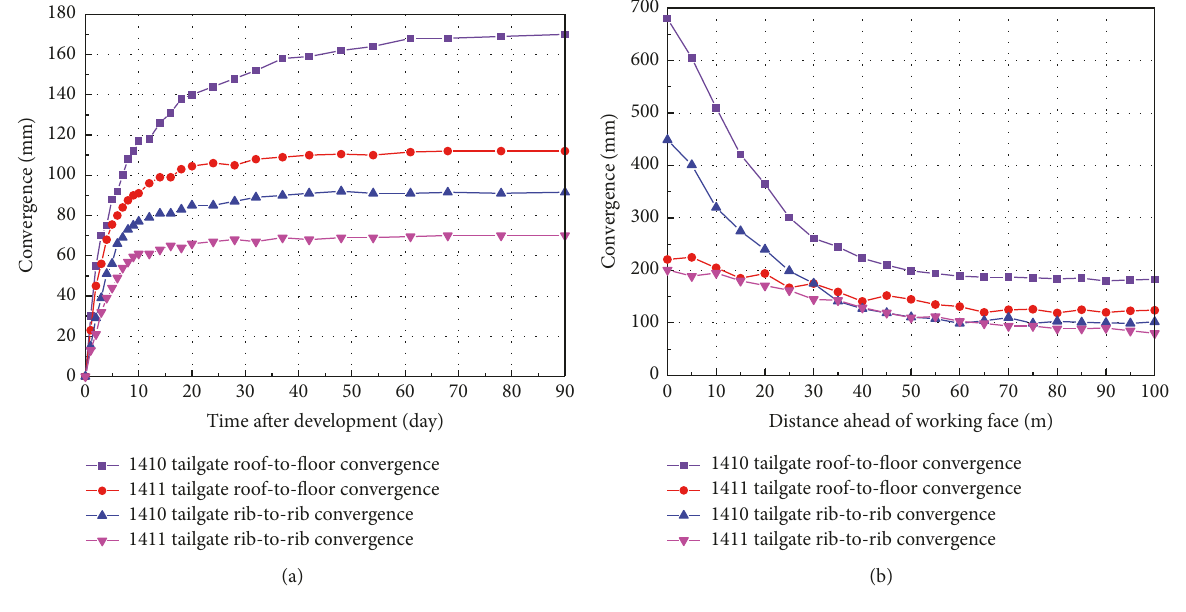
Figure 19: Field measurement of convergences of 1410 and 1411 tailgates. (a) Convergences of 1410 and 1411 tailgates against time after development. (b) Convergences of 1410 and 1411 tailgates against distance ahead of working face.